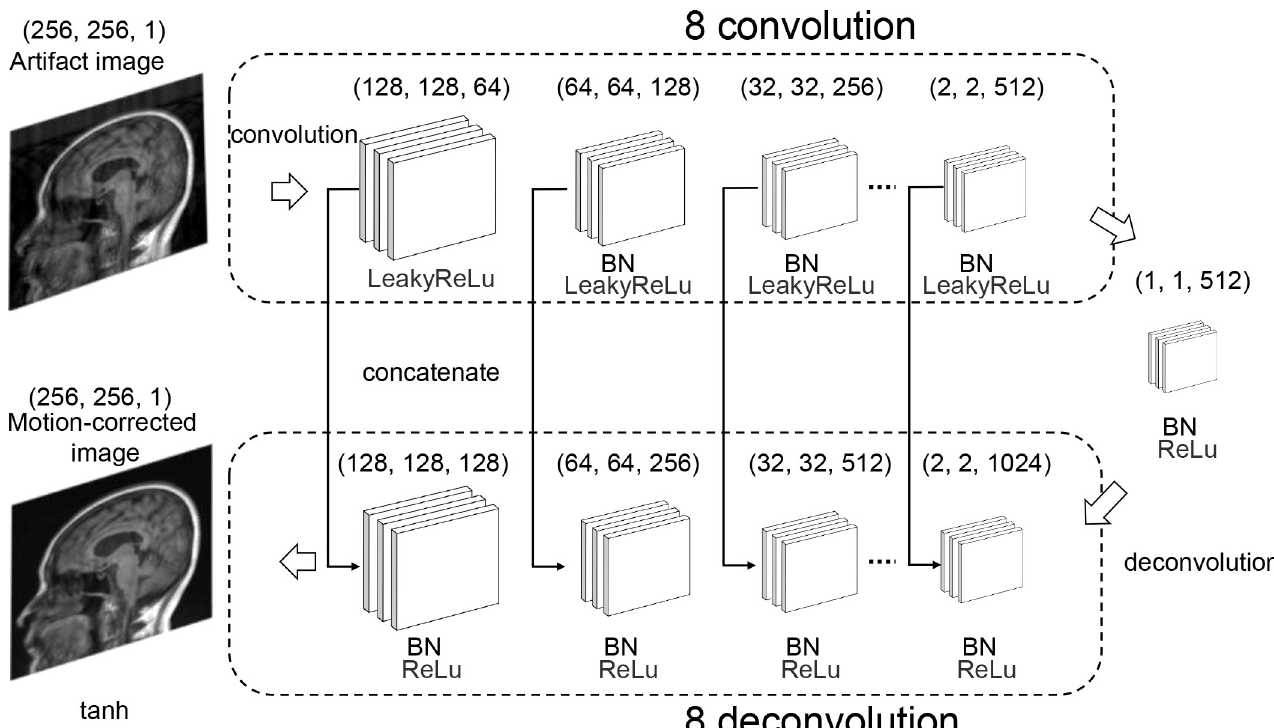
Fig 4. Generator network. We used a U-Net-based network for the generator network. This network comprised an encoder consisting of eight convolutional layers and a decoder consisting of the same number of deconvolutional layers. For the convolutional layer’s input and output, activation by the LeakyReLu function and batch normalization (BN) were performed in the encoder stack, whereas activation by the ReLu function and BN was performed in the decoder stack. The motion-corrected image was the output of the decoder stack activated by the tanh function.